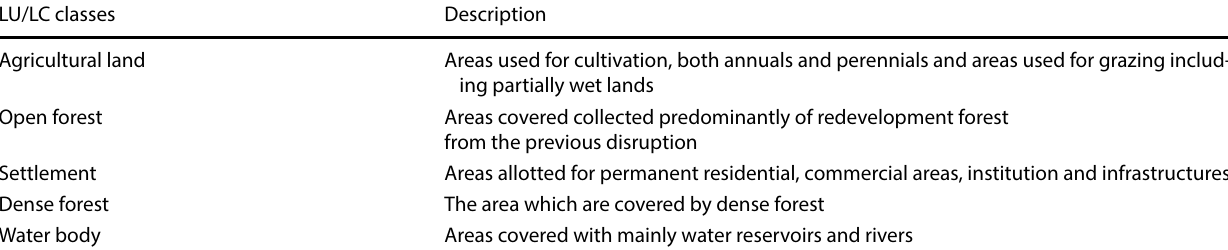
Table 2 Descriptions of LULC classes used in the study area LU/LC